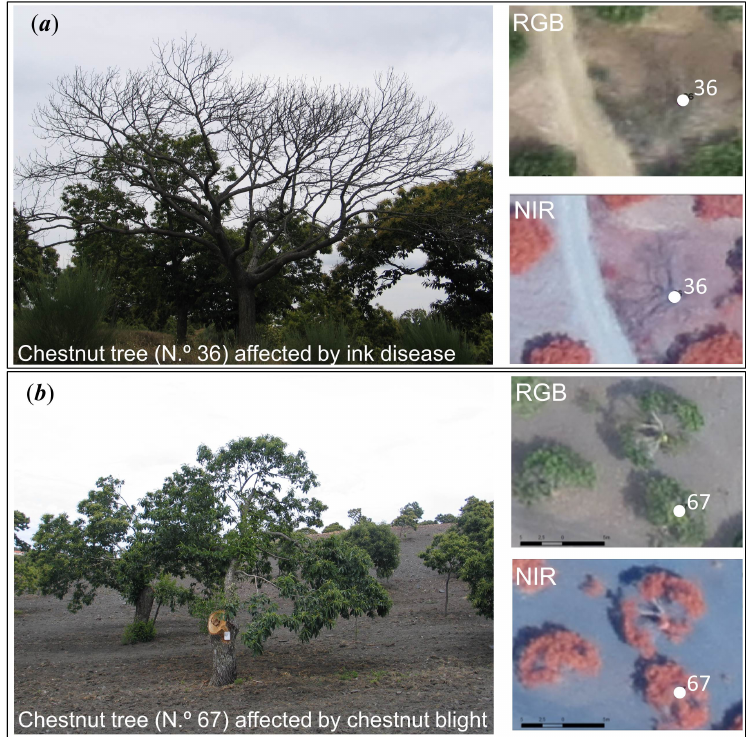
Figure 4. Chestnut trees affected by ( a ) ink disease and ( b ) chestnut blight. The same trees are represented in color and infrared aerial photographs. NIR: